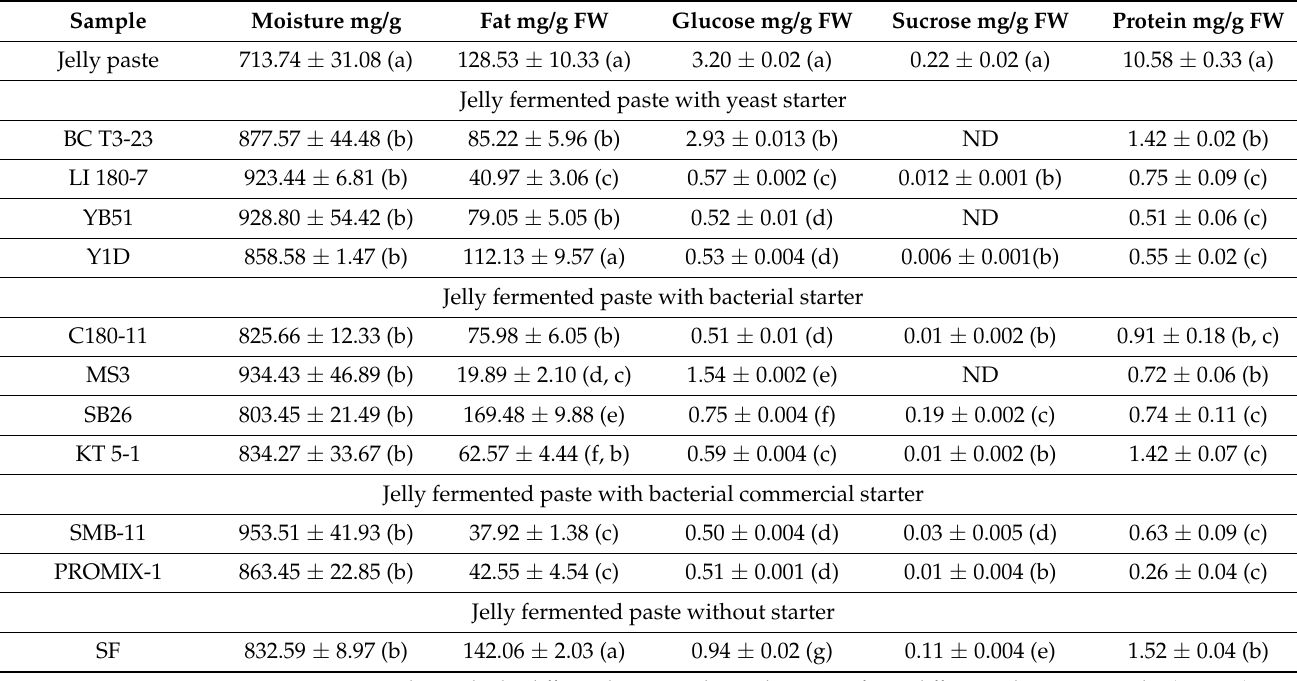
Table 4. Effect of selected microbial starter cultures on fermented Jellyfish paste samples.